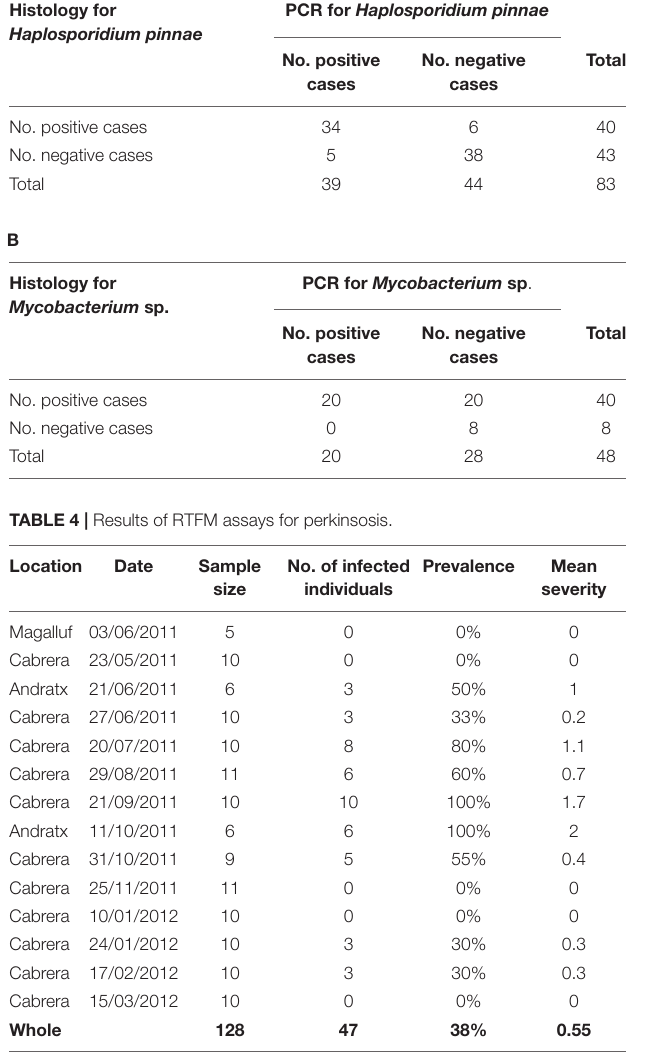
TABLE 3 | Contingency tables for comparison between diagnostic procedures, histology and PCR assays, for Haplosporidium pinnae (A) and mycobacteria (B) . A Histology for Haplosporidium pinnae